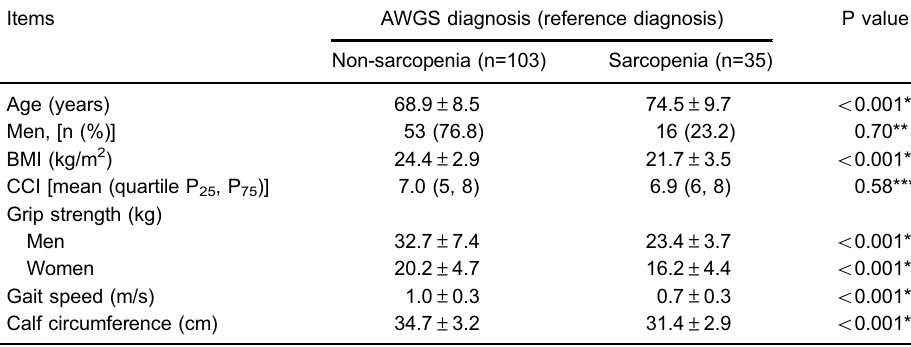
Table 1. Comparison of characteristics and clinical features of the